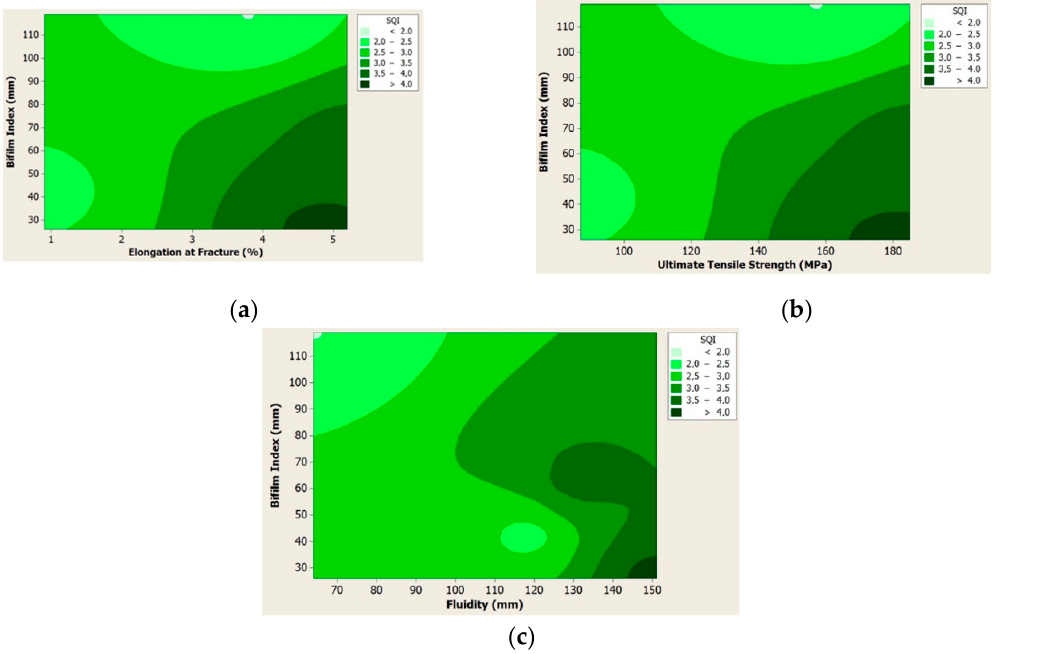
Figure 16. Contour maps of SQI and the bifilm index with ( a ) elongation at fracture, ( b ) UTS and ( c ) fluidity.